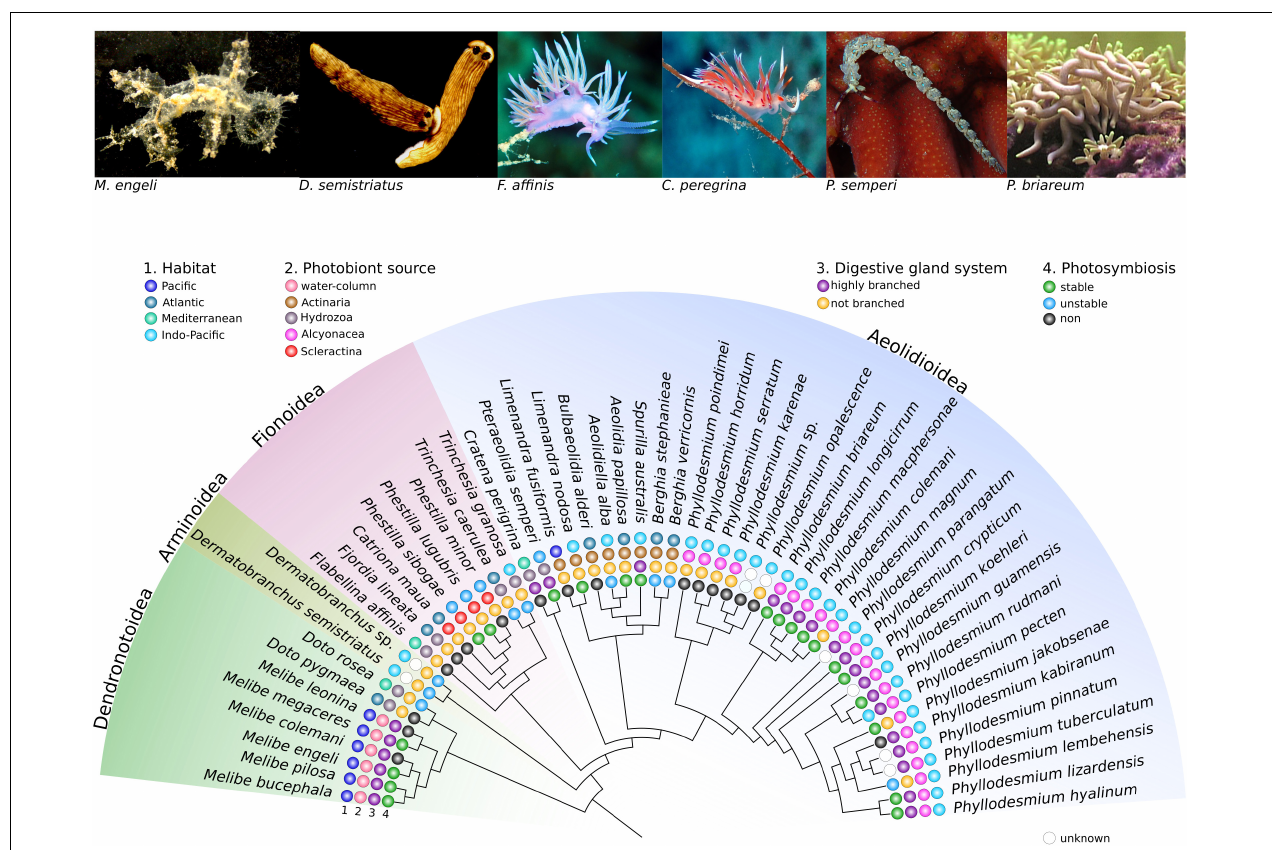
FIGURE 1 | Cladogram of selected Cladobranchia species showing different levels of photosymbiosis. Members of Cladobranchia are widespread distributed (1. Habitat) and acquire their photobiont horizontally either from the water column or by feeding on photosymbiotic cnidarians (2. Photobiont source). Different degree of ramification of the digestive gland system is present in Cladobranchia (3. Digestive gland system) that might be correlated to the stability of the photosymbiosis (4. Photosymbiosis). The cladogramm and the respective information are based on published data (Wägele and Willan, 2000; Johnson and Gosliner, 2012; Moore